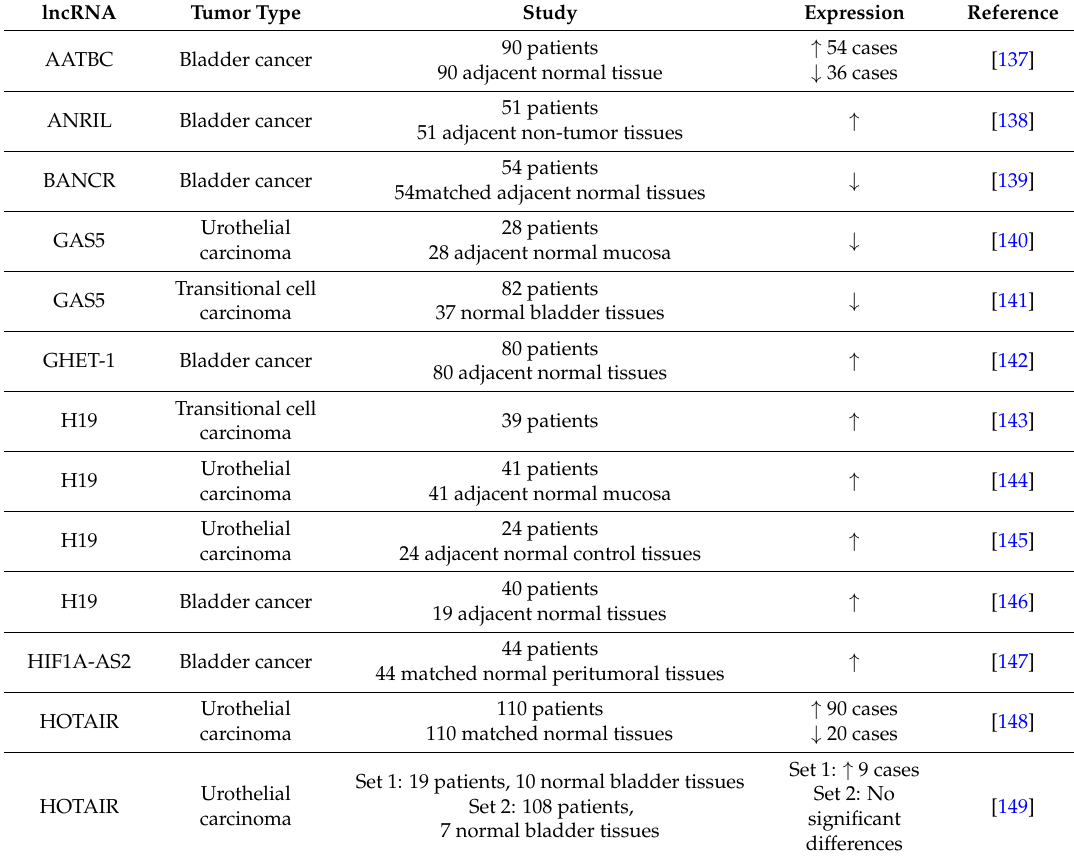
Table 2. Studies assessing the expression of different long non-coding RNAs (lncRNAs) in bladder cancer